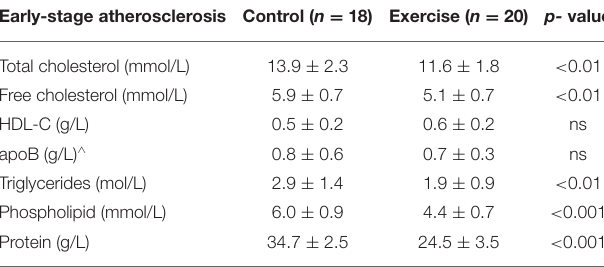
TABLE 2 | The effect of exercise on the lipid profile of the early-stage atherosclerosis mouse